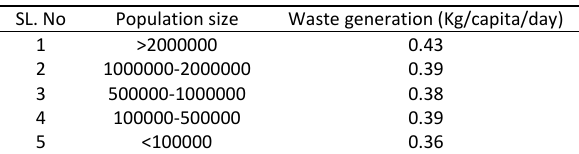
Table 1: Per-capita waste generation rate (CPCB Report, 2013)